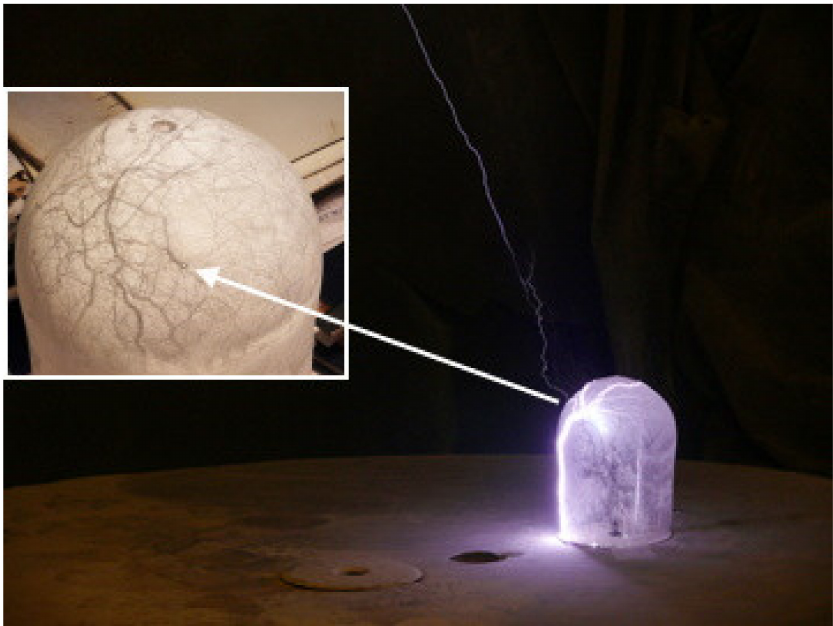
Figure 4. Puncture of radome’s shell due to accumulation of charges on the outer and inner surfaces of the radome.